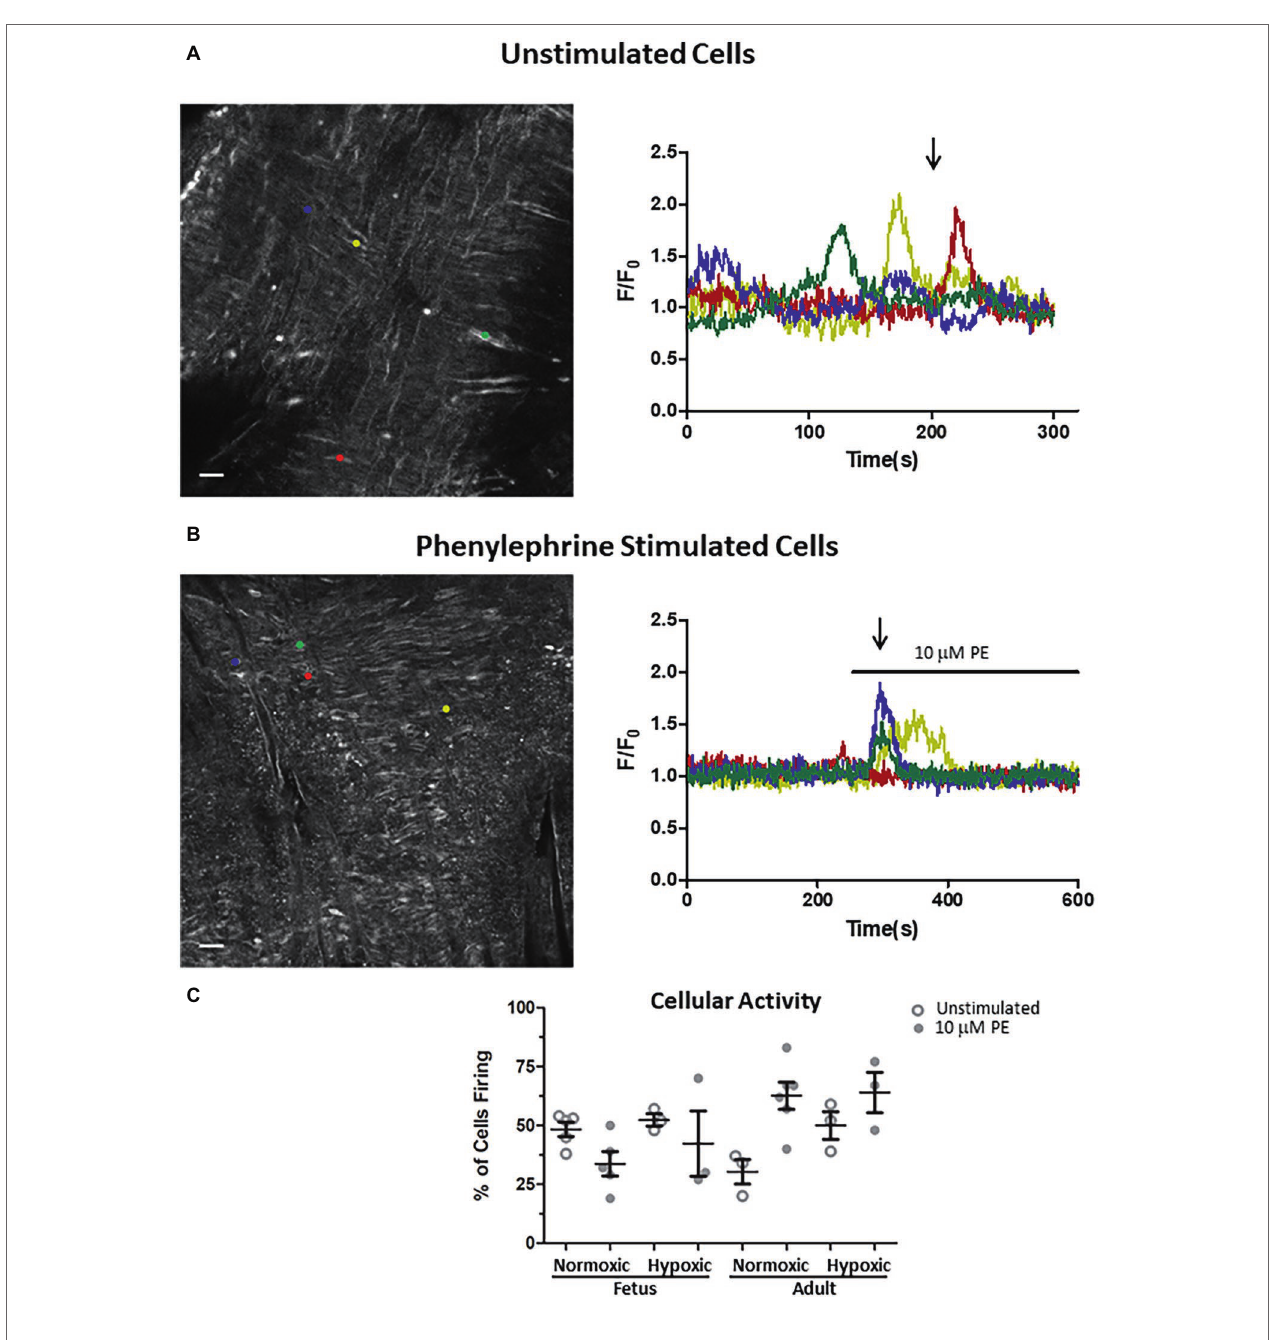
FIGURE 6 | Impact of LTH in the fetal and adult periods on unstimulated and PE-mediated whole-cell Ca 2+ responses in pulmonary arterial myocytes. Shown are representative fluorescent images at time points shown by the arrow and the traces of fractional Fluo-4 fluorescence for unstimulated (A) and 10 μM phenylephrine stimulated (B) arteries. (C) Percentage of myocytes in a 1,000 μm 2 area that had Ca 2+ responses to 10 μM PE under unstimulated (open circles) and stimulated (filled circles) conditions based on the number of runs examined. Colored circles on each image correspond to the placement of regions of interest for the traces of the same color in the tracing. About 10 μM phenylephrine was present during the time period denoted by the horizontal bar. Images were made with a 20× non- immersion objective (NA 0.8). Scale bar is 25 μm. Numbers of animals for each group are provided in the “Methods”